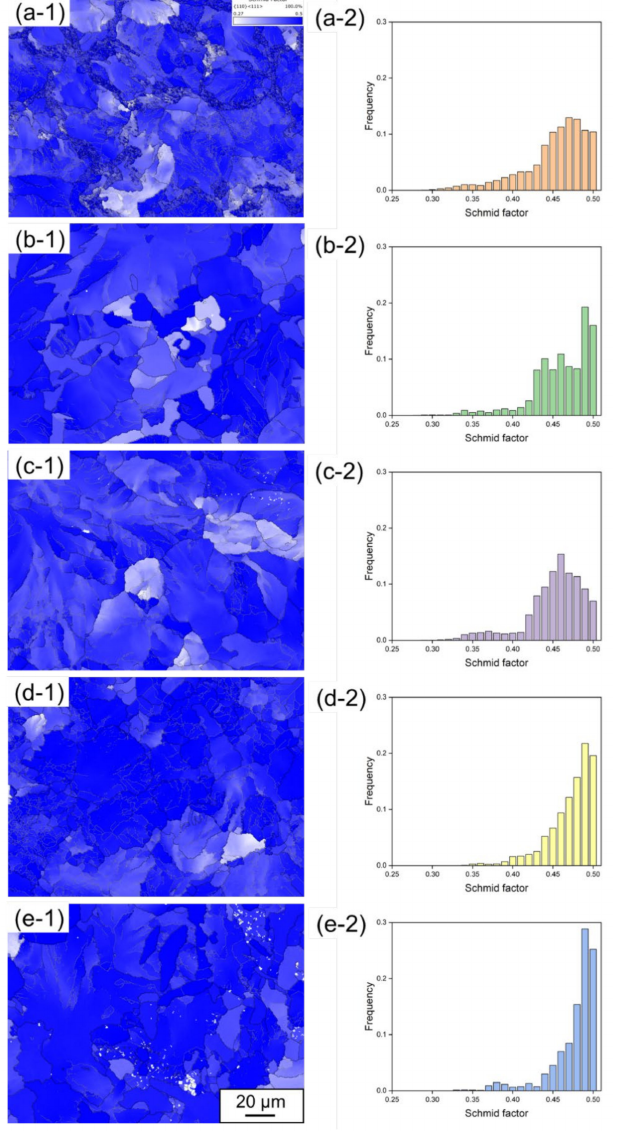
Figure 6. Schmid factor + grain boundary maps and corresponding distribution diagrams of Schmid factor for the rail steels: ( a ) 1904, ( b ) 1911, ( c ) 1917, ( d ) 1919, ( e ) 1921, noted as (-1) and